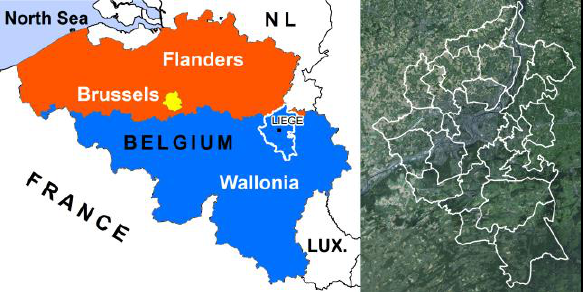
Figure 1. Area of Interest: Wallonia, Belgium (left); Liège district with 24 municipalities